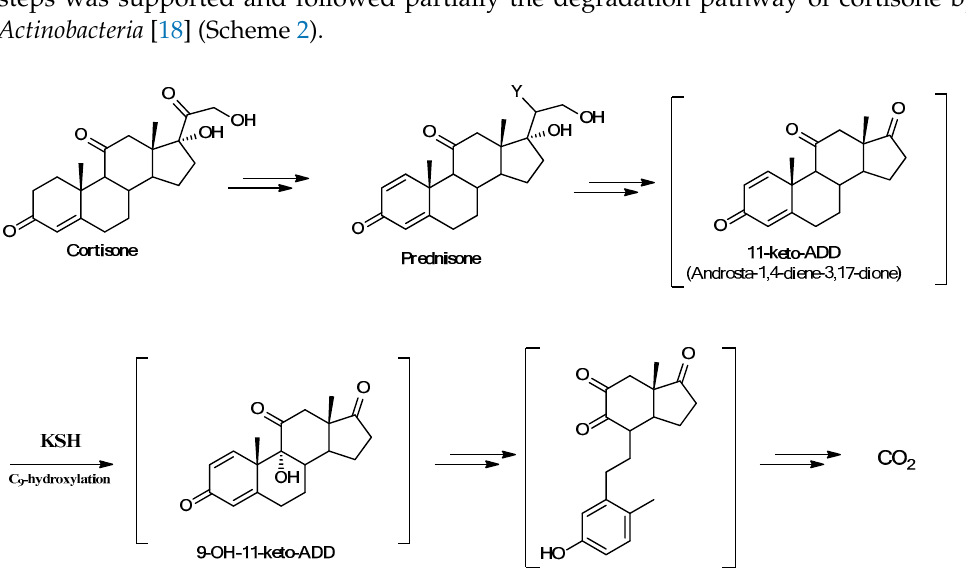
Figure 2. 3-(4,5-Dimethylthiazol-2-yl)-2,5-diphenyltetrazolium bromide (MTT) test about the cell viability of the aneuploid immortal keratinocyte c ell line after exposure to product 6 ( a ) and product 7 ( b ). The values were expressed as a percent- age with respect to the control (C = 100%) to the vehicle alone and reported as mean ±